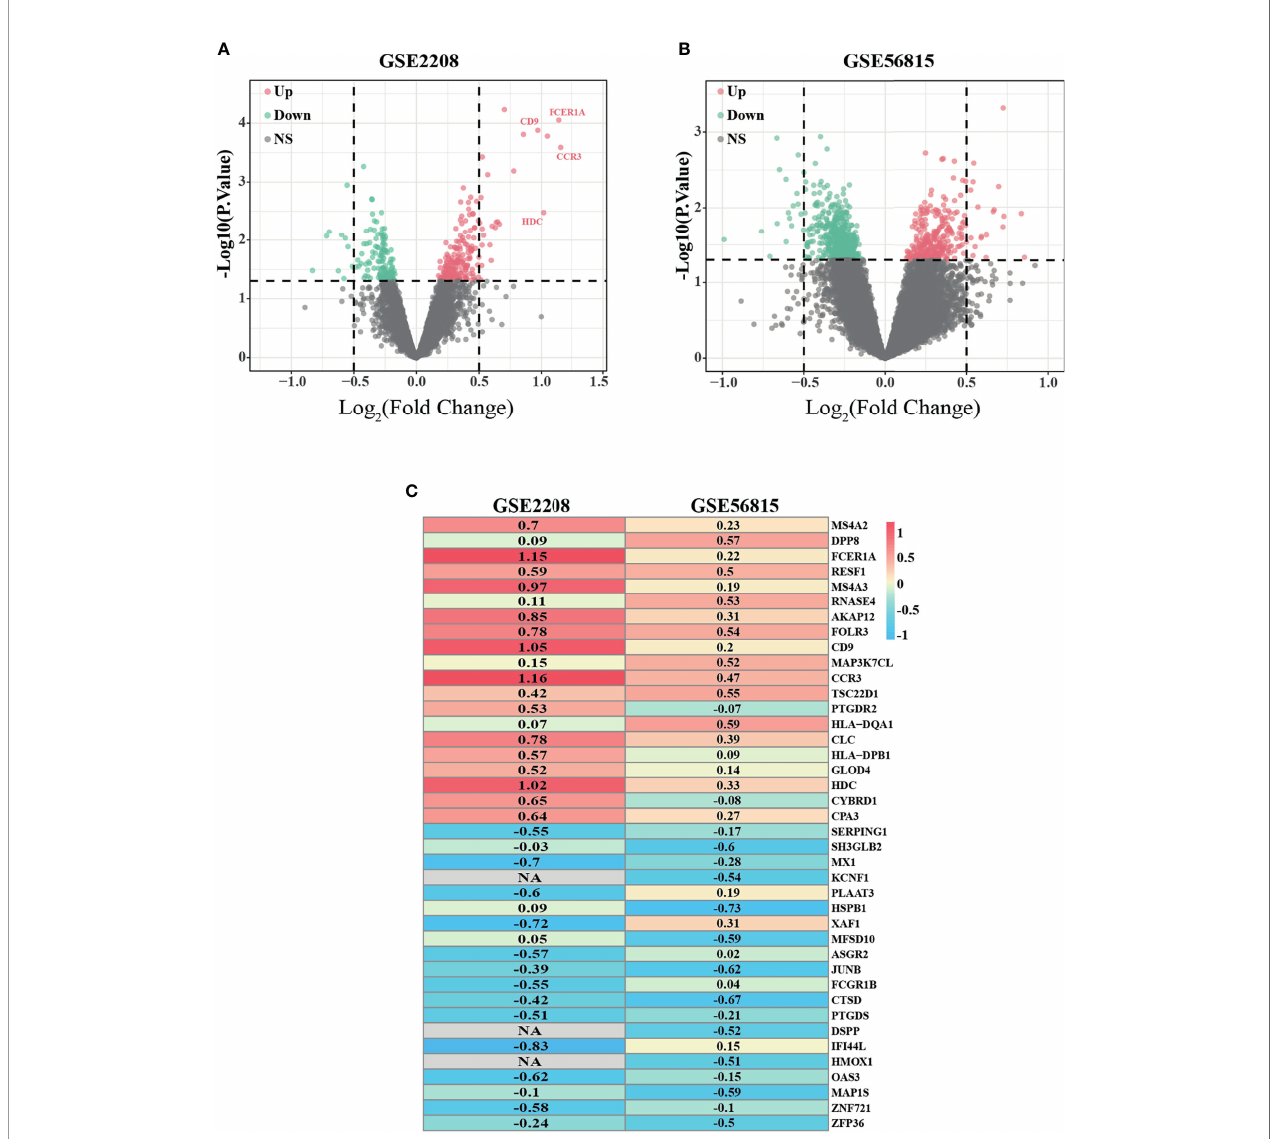
FIGURE 1 | Identi fi cation of differentially expressed genes (DEGs) with the cut off criteria of P-Value <0.05. (A) Volcano plot of DEGs for GSE2208 datasets. (B) Volcano plot of DEGs for GSE56815 datasets. (C) The heatmap of top 40 (20 upregulated DEGs and 20 downregulated DEGs) DEGs according to RRA algorithm. As the color goes from red to blue, indicating the changing from up to downregulation. NA represents genes with no statistical signi fi cance in GSE2208, but it can be re fl ected in RRA algorithm because of its high ranking and small P value in GSE56815. Similar results can be referenced in